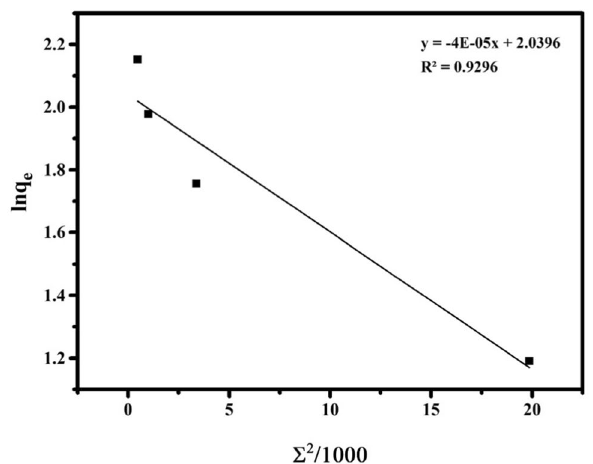
Fig. 11 Pseudo-first-order kinetic model for the adsorption of MB dye on the PBF surface